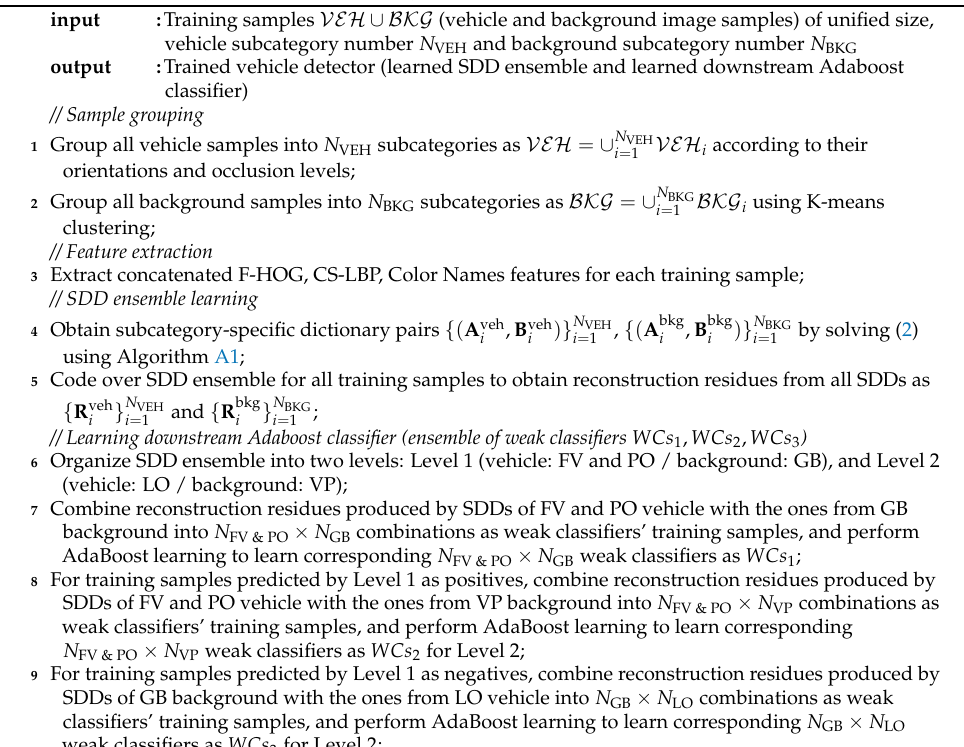
Algorithm 1: Algorithm for training